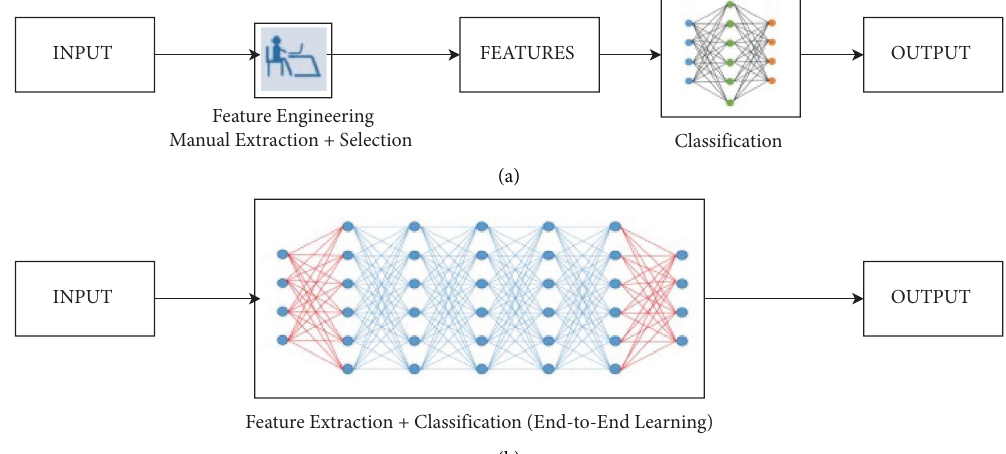
Figure 1: (a) Traditional image processing model and (b) deep learning model. Source: [7].